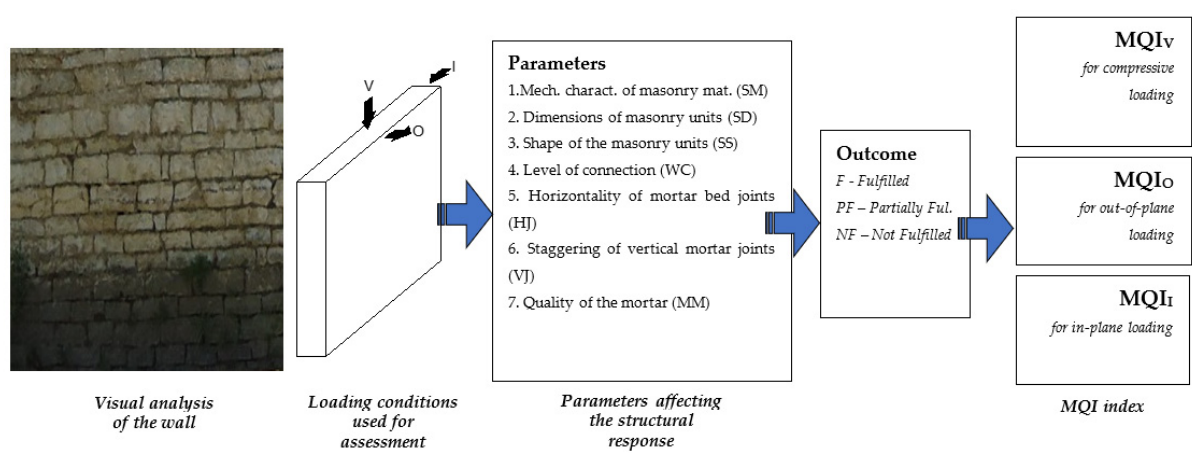
Figure 14. Summary of the MQI (Masonry Quality Index) method.